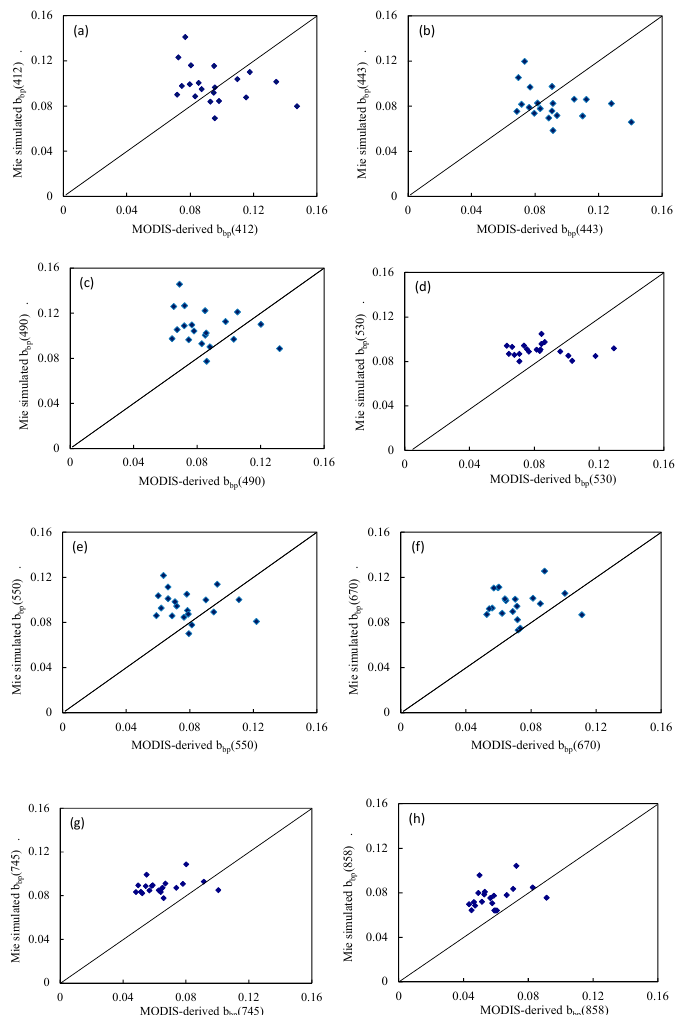
Figure 3. Comparison of the backscattering coefficients estimated by the Mie calculations and the MODIS images on November 21, 2004.